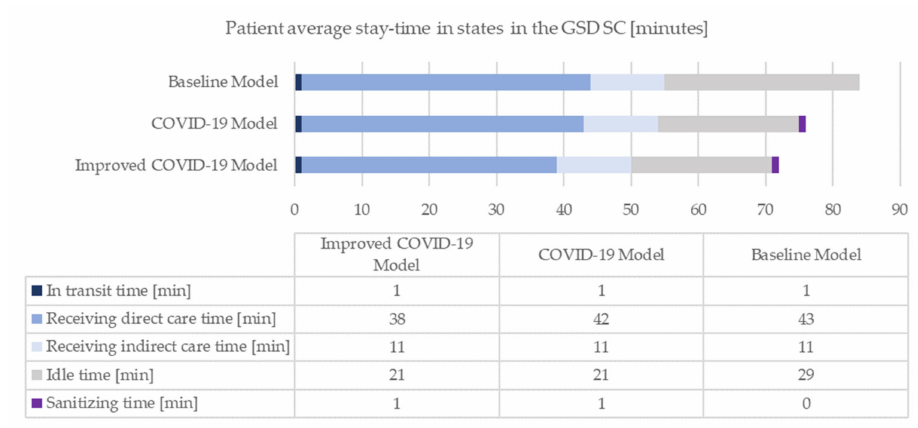
Figure 5. Patient average stay-time in the GSD